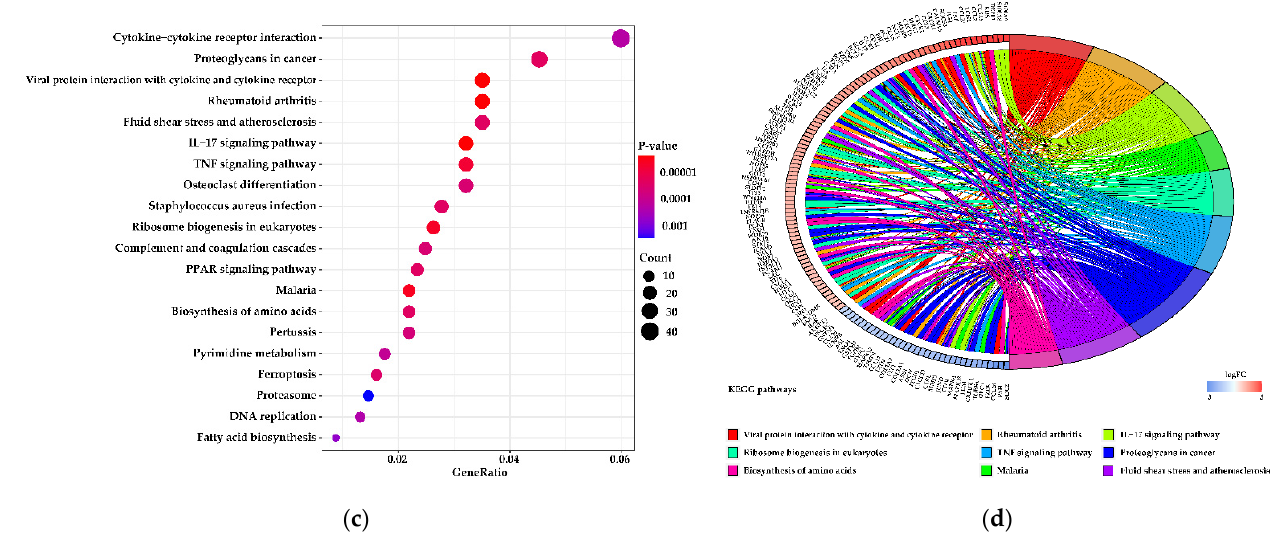
Figure 5. Kyoto Encyclopedia of Genes and Genomes (KEGG) pathway enrichment analysis of differentially expressed genes (DEGs). ( a , c ) Figures, respectively, show the top 10 significant KEGG pathways of each category from ( a ) the 90 vs. 180 d group and ( c ) the 90 vs. 270 d group. ( b , d ) Circos plots showing overlapping and specific responses of DEGs enriched in the top nine KEGG pathways.